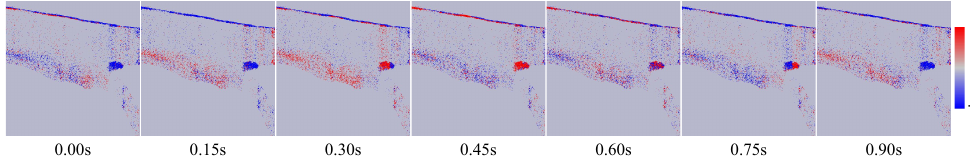
Figure 8. OCT PhDiff signal at anterior chamber during one